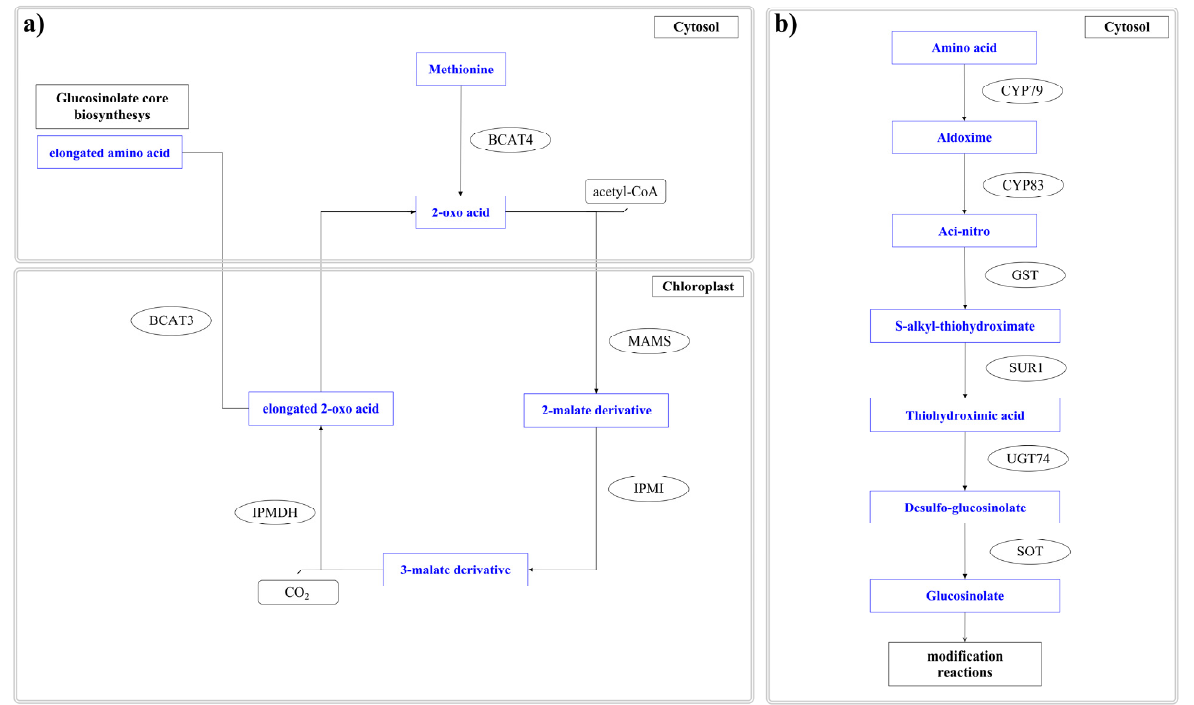
Figure 3. ( a ) Schematic representation of the biochemical processes involved in the aliphatic Glucosinolate Chain Elongation machinery; ( b ) Glucosinolate Core Biosynthesis. Amino acids, including elongated aliphatic methionine-derived molecules, can be converted to aldoximes by members of the CYP79 cytochrome P450 family to start building up the core glucosinolate scaffold. BCAT4 - branched-chain aminotransferase 4; MAMS—methylthioalkylmalate synthase; IPMI— isopropylmalate isomerase; IPM-DH—isopropylmalate dehydrogenase; BCAT3—branched-chain aminotransferases-3; CYP79; GST; SUR1; UGT74; SOT. The pathway was built using the open- source software Pathvisio vs. 3.3.0.